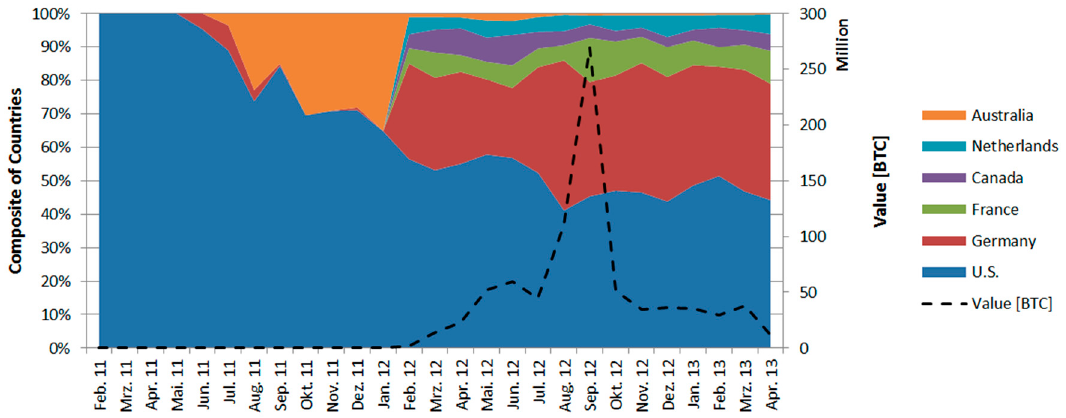
Figure 16. Composite of Developed Countries over Time (Value in BTC).